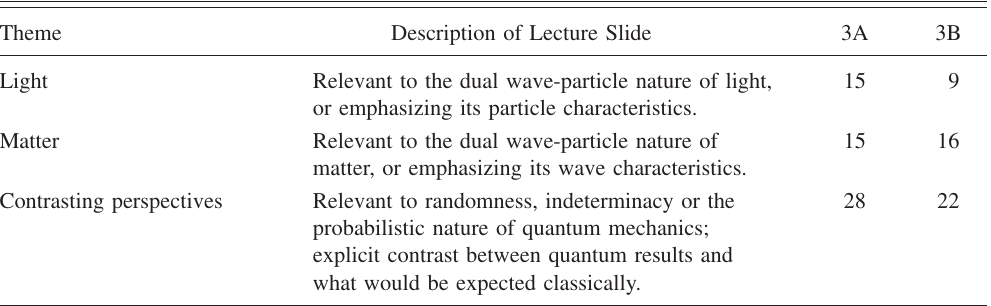
TABLE II. Description of lecture slides relevant to three key themes in promoting nonclassical perspec- tives, and the point totals for each of the two modern physics courses.